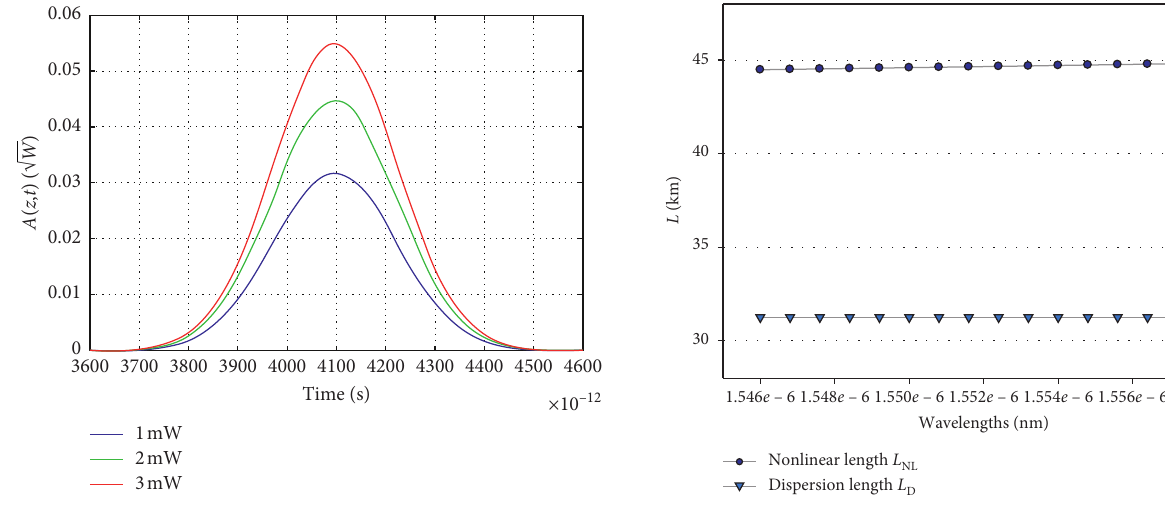
Figure 7: Variation of L D and L NL at different values of wave- lengths in